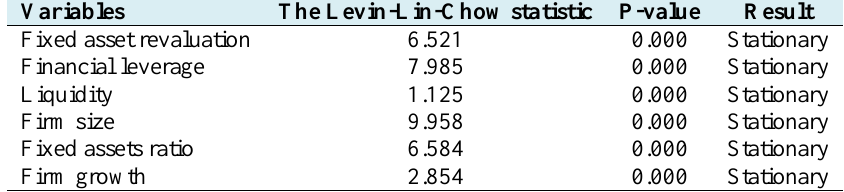
Table 15. The results of testing the stationarity of research variables in the BSE